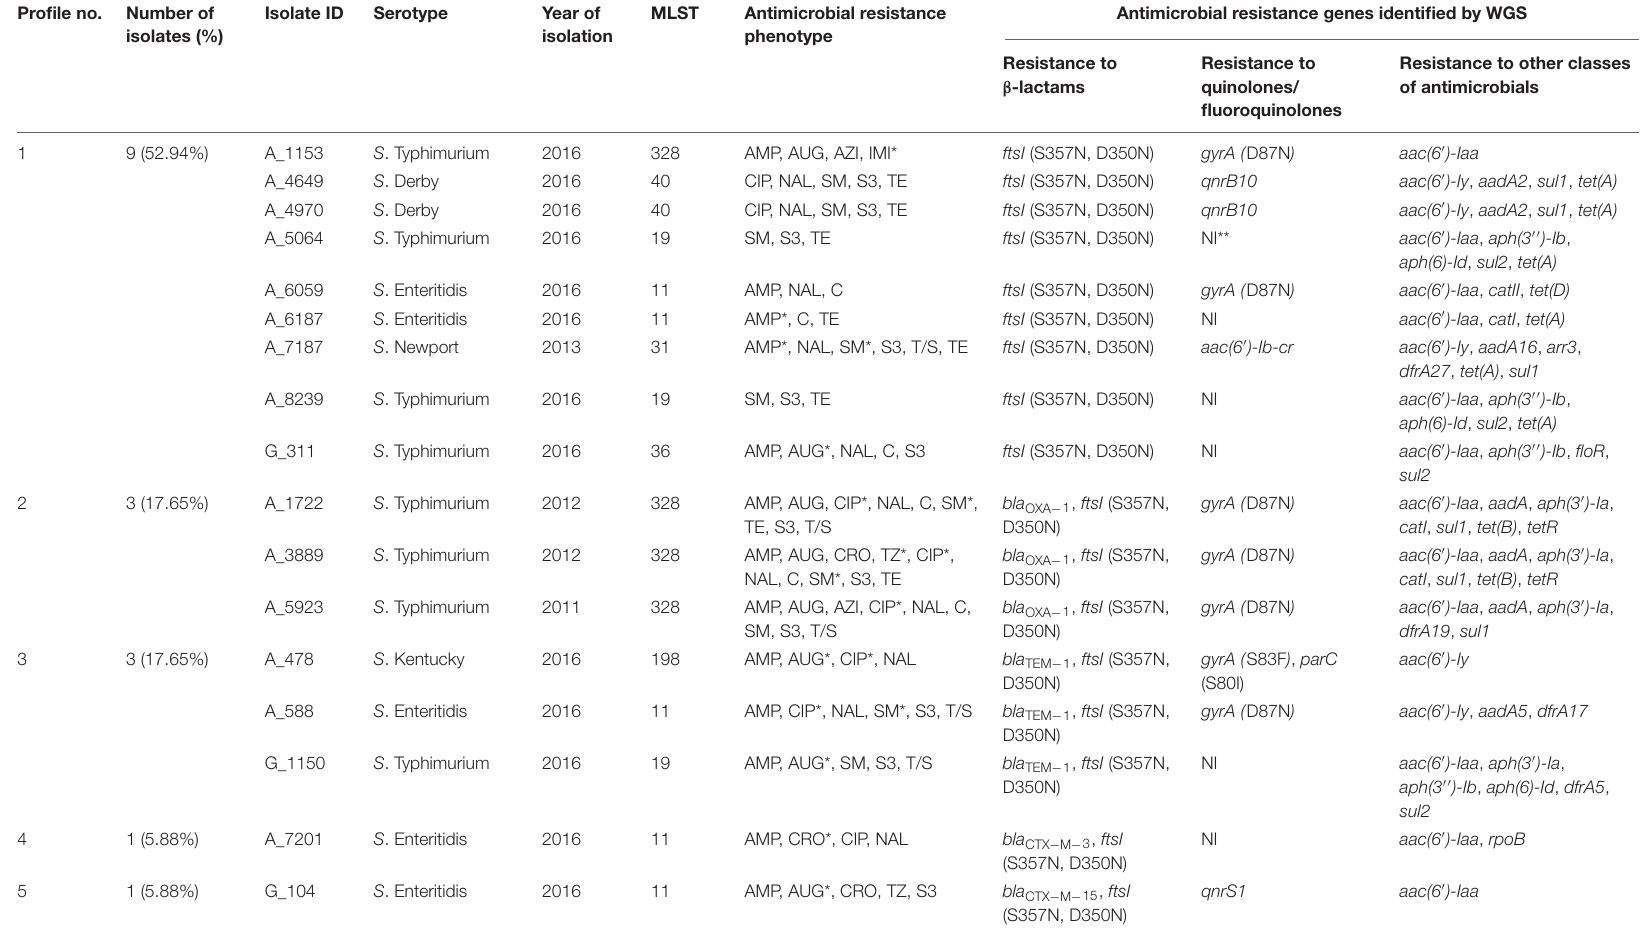
ESBL, extended-spectrum beta-lactamase; MDR, multidrug-resistant; NTS, non-typhoidal Salmonella; MLST, multi locus sequence type; WGS, whole genome sequencing; AMP, ampicillin; AUG, amoxicillin-clavulanic acid; AZI, azithromycin; C, chloramphenicol; CIP, ciprofloxacin; CRO, ceftriaxone; TZ, ceftazidime; IMI, imipenem; NAL, nalidixic acid; SM, streptomycin; TE, tetracycline; T/S, trimethoprim-sulfamethoxazole; S3, sulfonamides. *Intermediate susceptibility to antimicrobial agent. **Not identified